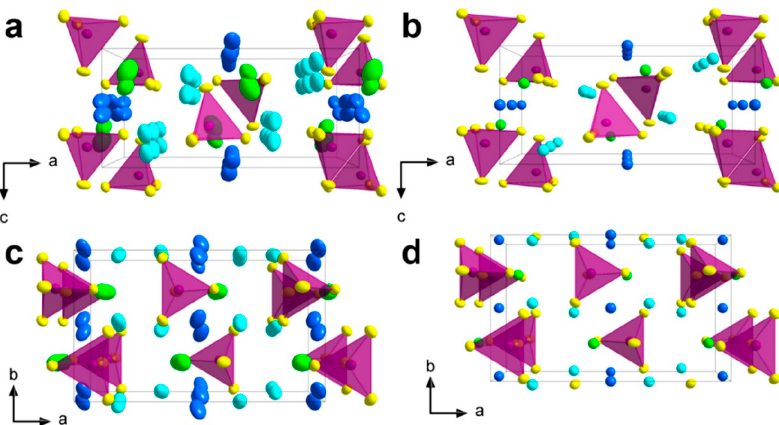
Figure 9. ( a ) Schematic representation of the structure of orthorhombic Li 3.25 [Si 0.25 P 0.75 ]S 4 derived from single-crystal data. ( b ) Structure of β -Li 3 PS 4 ( β -LPS) along the [010] direction. Views of ( c ) Li 3.25 [Si 0.25 P 0.75 ]S 4 and ( d ) β -LPS along the [001] direction. Here, the violet tetrahedra, turquoise spheres, Li(8 d )-2 (blue) in Li 3.25 [Si 0.25 P 0.75 ]S 4 /Li(4 b )-2 (blue) in β -Li 3 PS 4 , green spheres, and yellow spheres denote Li(4 c )-3A/B, and S atoms, respectively. Reproduced with permission from [222]. Copyright 2019 American Chemical Society.